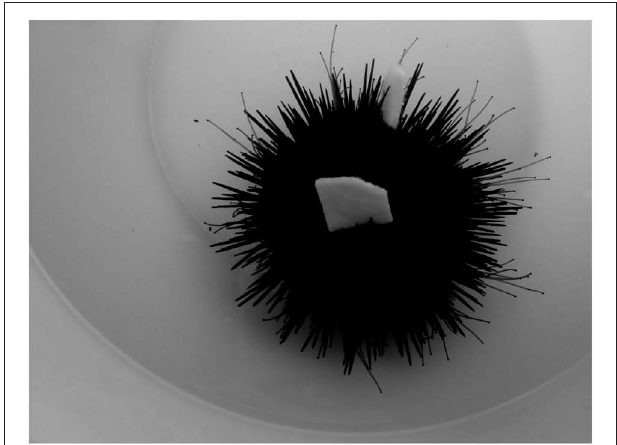
FIGURE 2 | Contact chemical stimulation of the sea urchins with absorbent cleaning cloths (simulacra). The one in the centre of the image was soaked with just background seawater (blank) and the other in the foreground, already transported to the oral region, was soaked with a chemical